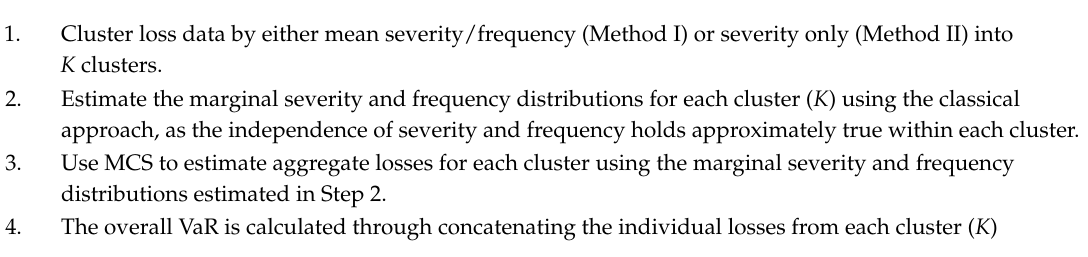
Algorithm 1 Data-driving partitioning of frequency and severity (DPFS) (Methods I and II) VaR